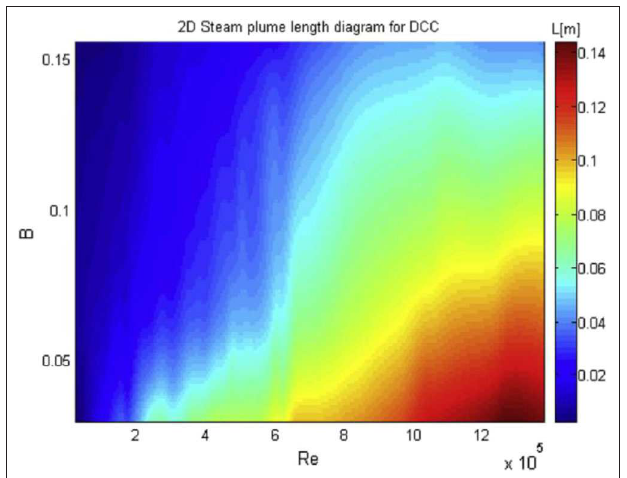
FIGURE 12 | The new diagram of steam plume length developed by De With (2009)